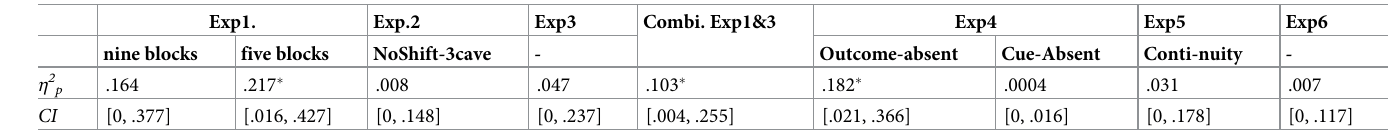
Table 4. Observed effect size and confidence